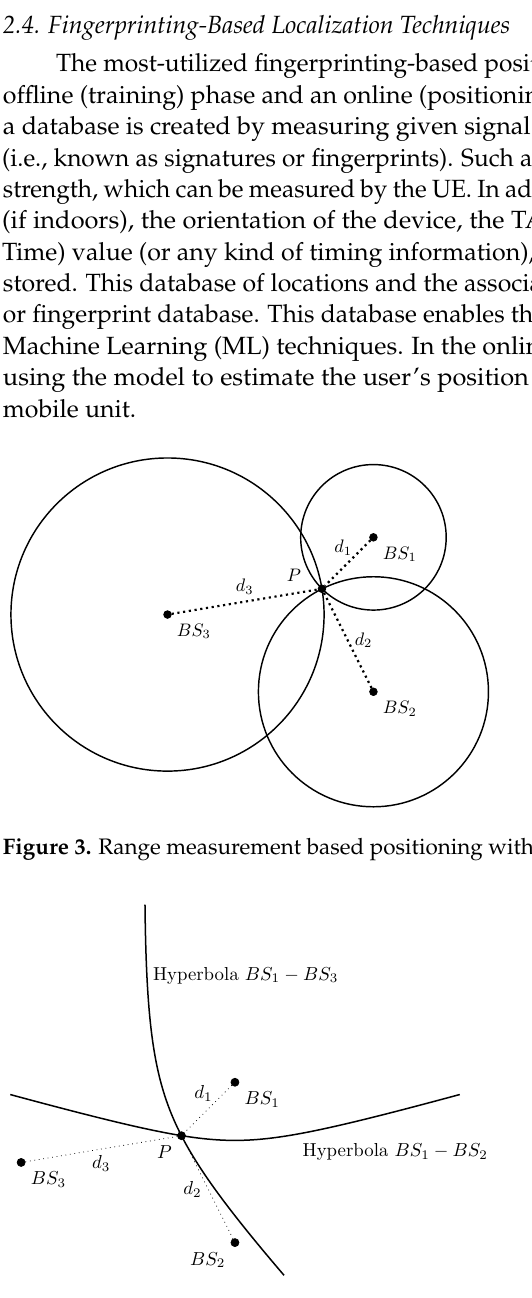
Figure 4. Range difference measurement based positioning with at least three Figure 4. Range-difference measurement based positioning with at least 3 BS.